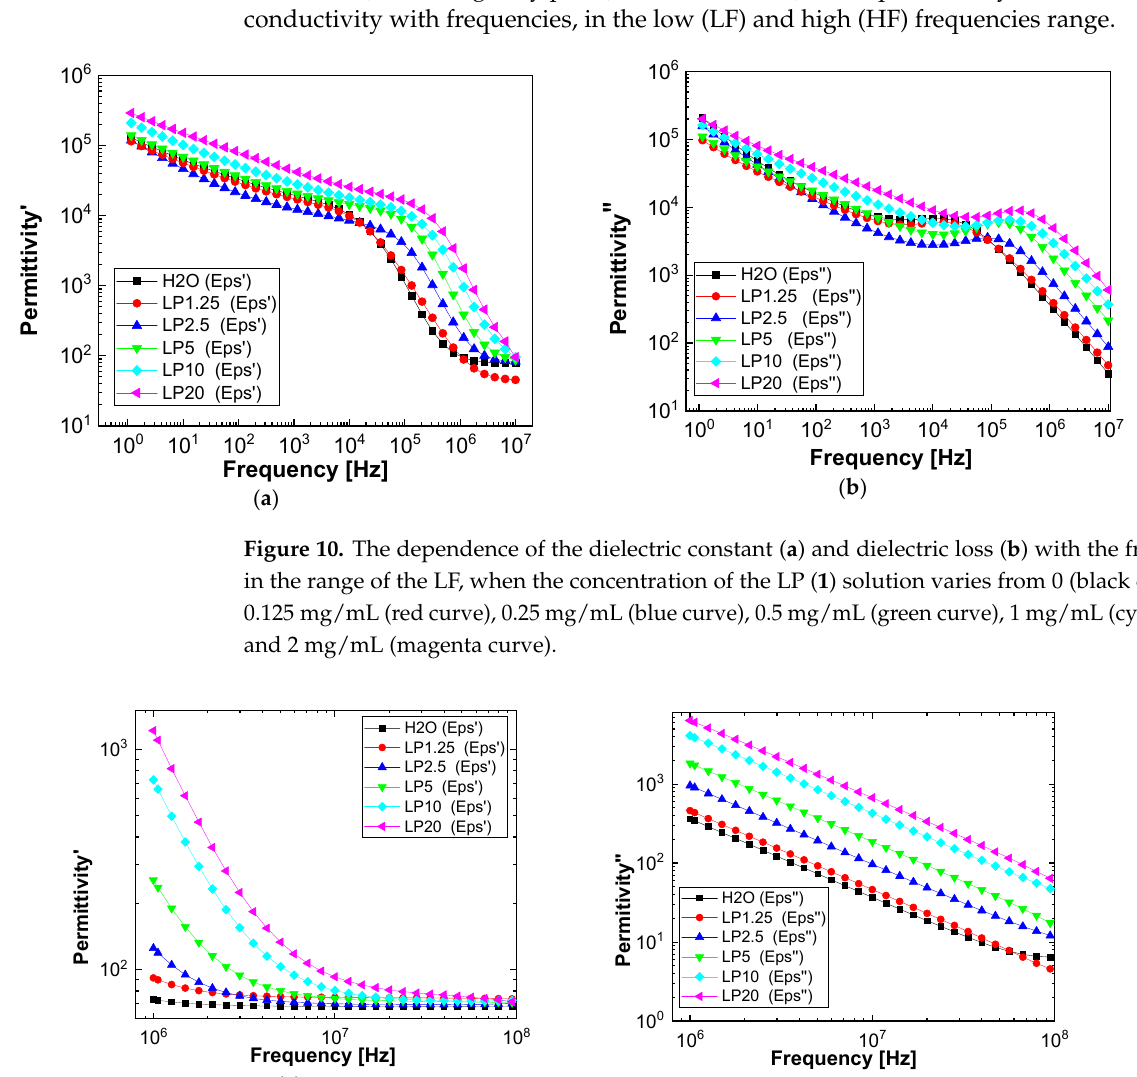
( b ) Figure 12. The dependence of real part of conductivity with frequency, in the range of low ( a ) and high ( b ) frequencies, when the concentration of the LP( 1 ) solution varies from 0 (black curve) to 0.125 mg/mL (red curve), 0.25 mg/mL (blue curve), 0.5 mg/mL (green curve), 1 mg/mL (cyan curve) and 2 mg/mL (magenta curve).